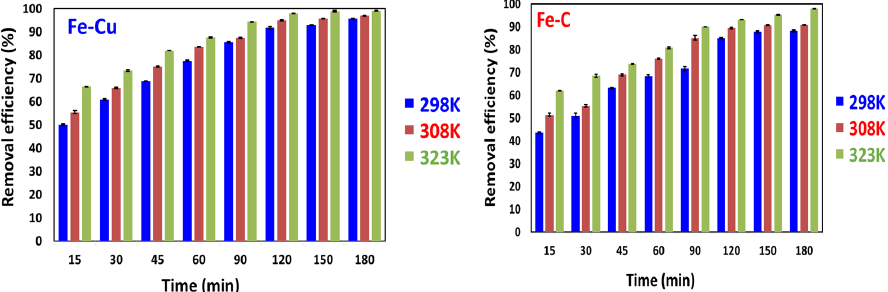
Figure 7. Effect of reaction temperature on CIP removal under Fe-Cu and Fe-C treatment.